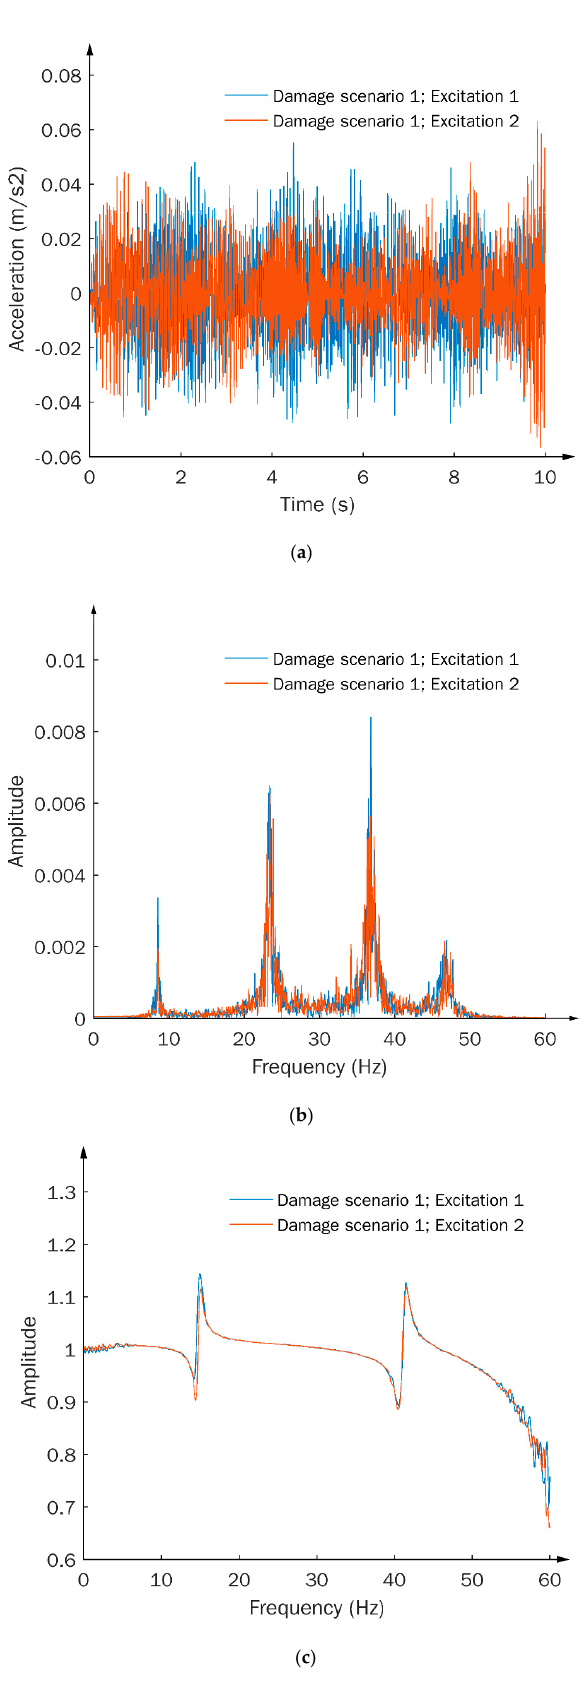
Figure 6. Dynamic responses in terms of ( a ) TS, ( b ) FFT-based, and ( c ) TF signals, subject to the same damage scenario and different excitation conditions.